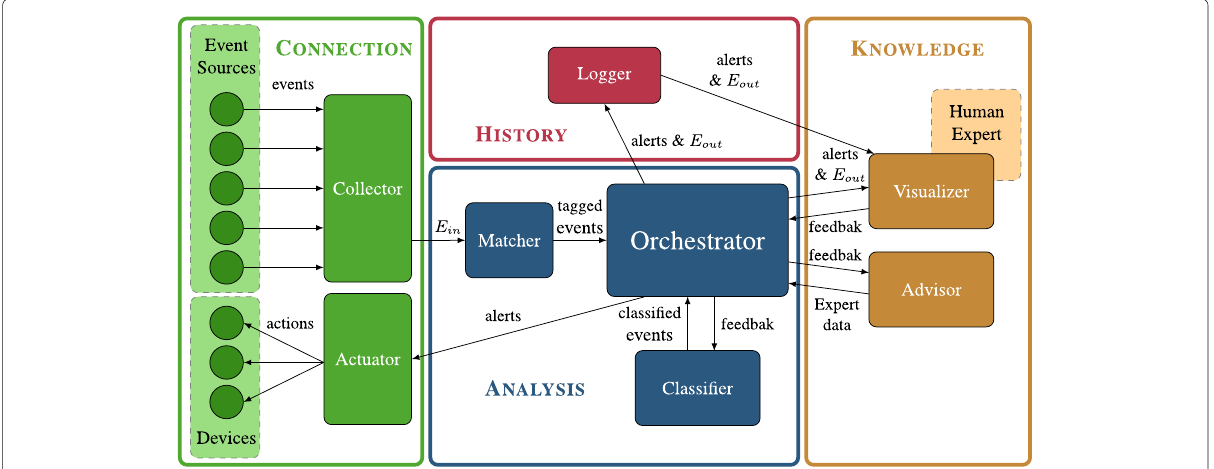
Fig. 4 Global architecture of OMMA (Operator-guided Monitoring of Multi-step Attacks). E in = input events filtered by the Collector. E out = enriched